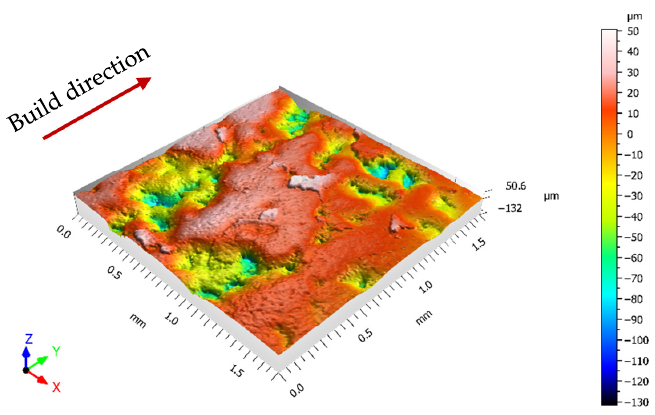
Figure 9. Topographical map of the 45°-sample heat-treated at 704 °C/120 ′ before the SB process.